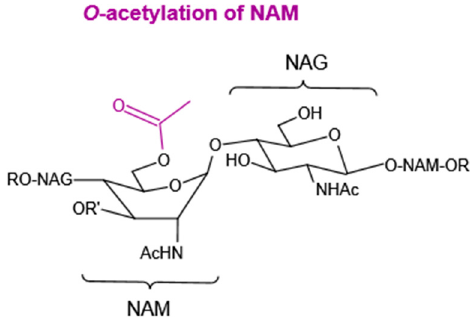
Figure 5. O -acetylation of NAM.